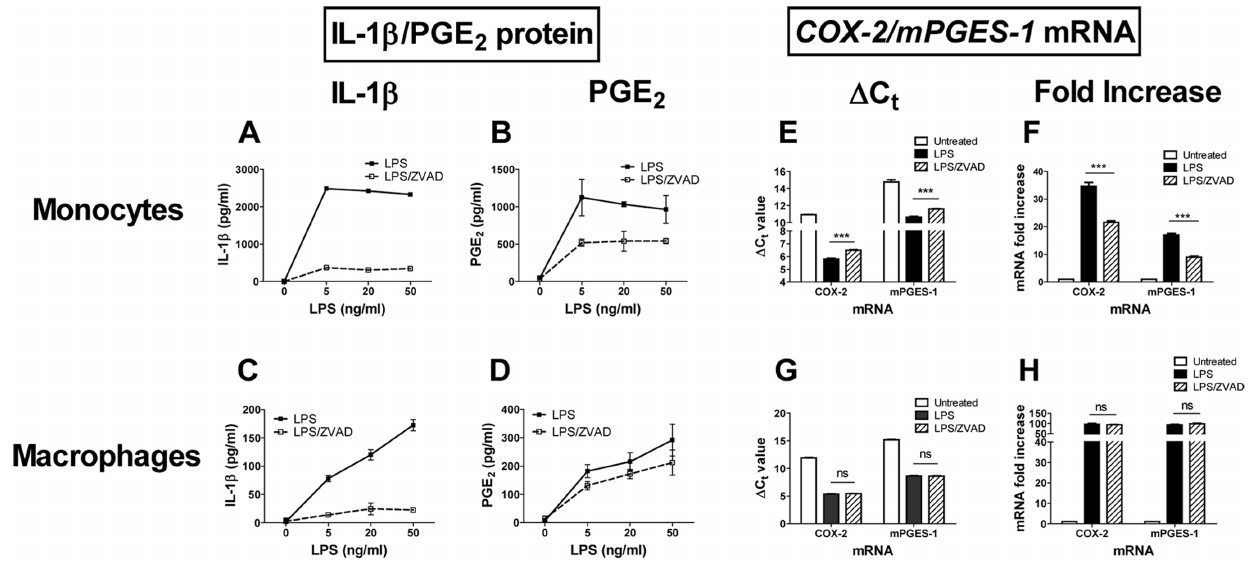
Figure 1. ZVAD reduced PGE 2 production and COX-2 / mPGES-1 mRNA expression in LPS-activated monocytes but not macrophages. Monocytes (A, B, E, F) and differentiated macrophages (C, D, G, H) were cultured with LPS at indicated concentrations in the absence (solid lines in A– D) or in the presence of ZVAD (A–D, broken lines). After overnight incubation, cell culture supernatants were assayed for IL-1 b (A, C) and for PGE 2 (B, D). The data is shown as mean 6 STDEV for PGE 2 and IL-1 b protein concentration calculated for triplicate wells. Monocytes (E, F) and macrophages (G, H) were incubated alone (open bars) or with 20 ng/ml of LPS in the absence (solid bars) or in the presence of ZVAD (striped bars) and were assayed for COX-2 mRNA and for mPGES-1 mRNA expression at 6 and 12 h post treatment by qPCR in triplicate wells. The C t values for COX-2 and mPGES-1 mRNA expression in monocytes (E) and macrophages (G) were normalized using qPCR reactions with b -actin primers performed in the same samples and are shown as mean D C t 6 STDEV calculated for triplicate wells. Asterisks denote statistical significance of the differences in the means of D C t values between LPS-treated cells cultured with or without ZVAD. D C t values were used to calculate COX-2 and mPGES-1 mRNA fold increases over time 0 in monocytes (F) and macrophages (H), ***p # 0.001; ns, not significant (p $ 0.05). The experiment described in Figure 1 was performed 3 times with cells obtained from different donors. The data is shown for one representative donor. doi:10.1371/journal.pone.0098517.g001 D C COX-2 and mPGES-1 mRNA up-regulation, data not shown) by t values confirmed that up-regulation of COX-2 and mPGES-1 qPCR (Fig. 1 E, and G). In agreement with the data in panel D, mRNA expressions induced by LPS in macrophages were not the changes in COX-2 and mPGES-1 D C t values after LPS affected by ZVAD, while in monocytes, LPS-induced increase in both genes was reduced up to 50% by ZVAD compared to LPS treatment of macrophages were not affected by ZVAD (no change alone (Fig. 1F and H). in the C t values) (Fig. 1G). However, in monocytes, COX-2 and mPGES-1 D C t values were significantly higher in monocytes treated with LPS and ZVAD compared with LPS alone, indicating expression, cell lysates were prepared from monocytes and reduced levels of mRNA present (p # 0.001) (Fig. 1E). Calculated fold increases in COX-2 and mPGES-1 mRNA expression based on PAGE followed by Western Blotting with antibodies against